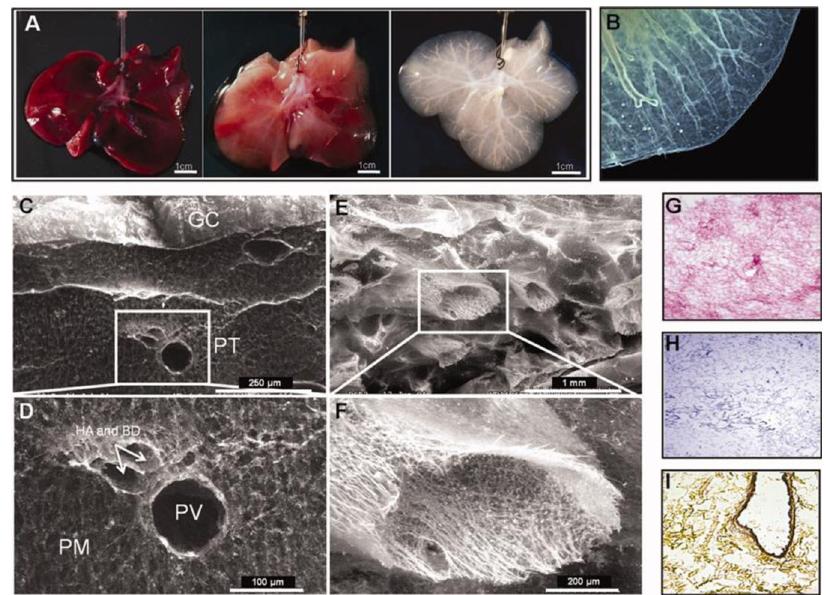
Fig. 3 An example of whole-organ ferret liver decellularization with excellent retention of structural information, for use as an organoid scaffold. Figure ( a ) shows the liver at the start of treatment, then after 20 and 120 min of decellularization. A micrograph of the decellularized liver, ( b ), shows that the liver capsule and vasculature remain intact after cell removal. Scanning electron microscope images show that the structure of the liver is remarkably well-conserved, with an intact Glisson ’ s capsule (GC) visible in ( c ), and an intact hepatic artery (HA), hepatic portal vein (PV), and biliary duct (BD) visible in ( d ). Other blood vessels are structurally intact, despite cell removal ( e ), with the structural details apparent even at high magni fi cation ( f ). H&E staining ( g ) shows that all cells have been removed, with the pink stain showing protein-containing extracellular matrix; this absence of cellular material is further con fi rmed by Mason ’ s Trichrome staining ( h ). Movat-Pentachrome staining ( i ) shows the presence of collagen in yellow, and a dark stain shows elastin around an artery. Decellularization can proceed gently enough to retain structural information, yielding scaffolds that can be colonized by pluripotent cells which then differentiate into mature organoids. The image is from ref. 74 and is reproduced with